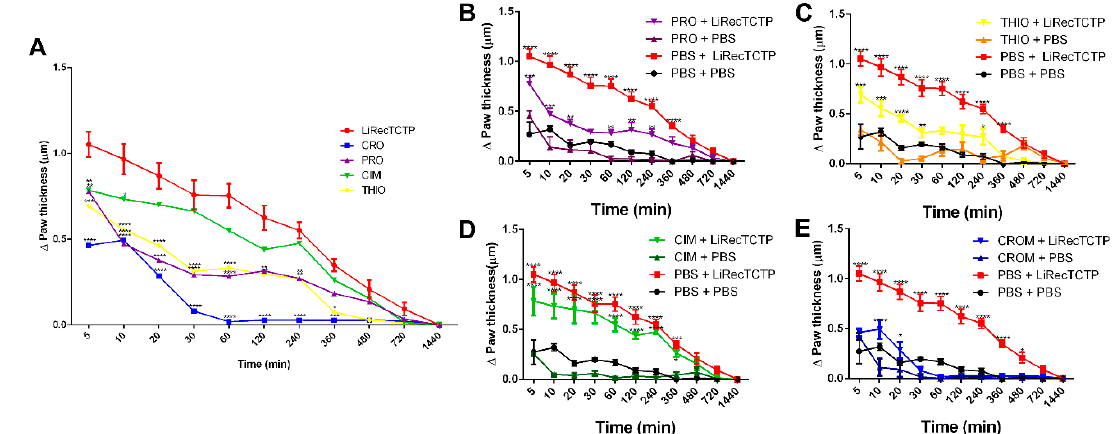
Figure 5. Effect of the treatment with the mast cell degranulation inhibitor or histamine receptor antagonists on edema induced by LiRecTCTP. Mice ( n = 5) were pre-treated with promethazine (PRO), cimetidine (CIM), thioperamide (THIO), cromolyn (CROM), or PBS (control), and thereafter, animals were injected with LiRecTCTP (10 µg) or PBS (control) into footpads for edema. ( A ) Paw edema observed after injection with LiRecTCTP, in animals previously treated with PBS (LiRecTCTP), mast cell degranulation inhibitor (CRO), or histamine receptor antagonists (PRO, CIM, THIO). ( B ) Paw edema observed after injection with LiRecTCTP or PBS, in animals previously treated with PBS or promethazine (PRO). ( C ) Paw edema observed after injection with LiRecTCTP or PBS, in animals previously treated with PBS or thioperamide (THIO). ( D ) Paw edema observed after injection with LiRecTCTP or PBS, in animals previously treated with PBS or cimetidine (CIM). ( E ) Paw edema observed after injection with LiRecTCTP or PBS, in animals previously treated with PBS or cromolyn (CROM). Values represent the thickness difference between the edema after injection with LiRecTCTP and initial before injections. Each point represents the mean ± s.e.m of five animals from one representative experiment from three independent biological replicates (* p < 0.1; ** p < 0.01; *** p < 0.001 and **** p < 0.0001).